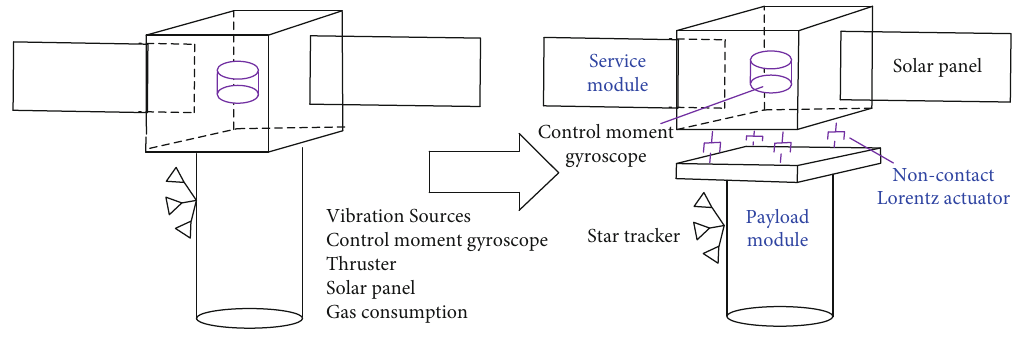
Figure 1: Hierarchical